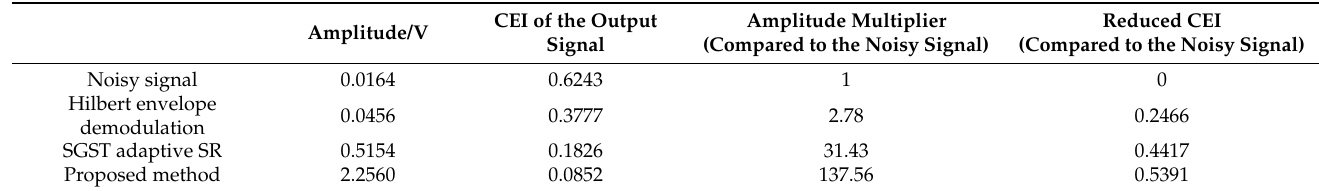
Table 2. The results of the three methods for simulated signals.